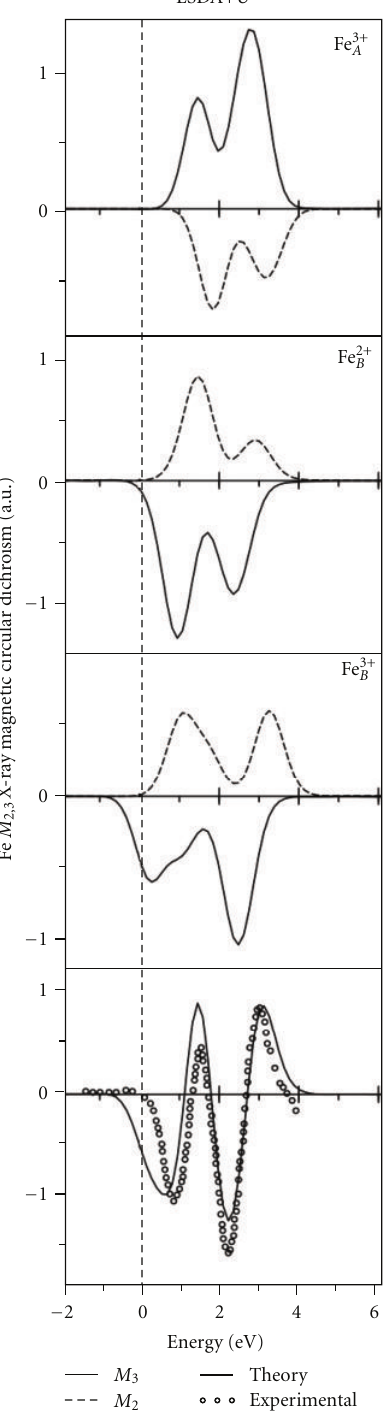
Figure 9: Fe M 2,3 XMCD spectra in Fe 3 O 4 calculated with the LSDA+ U approximation [191] in comparison with the experimen- tal data (circles)